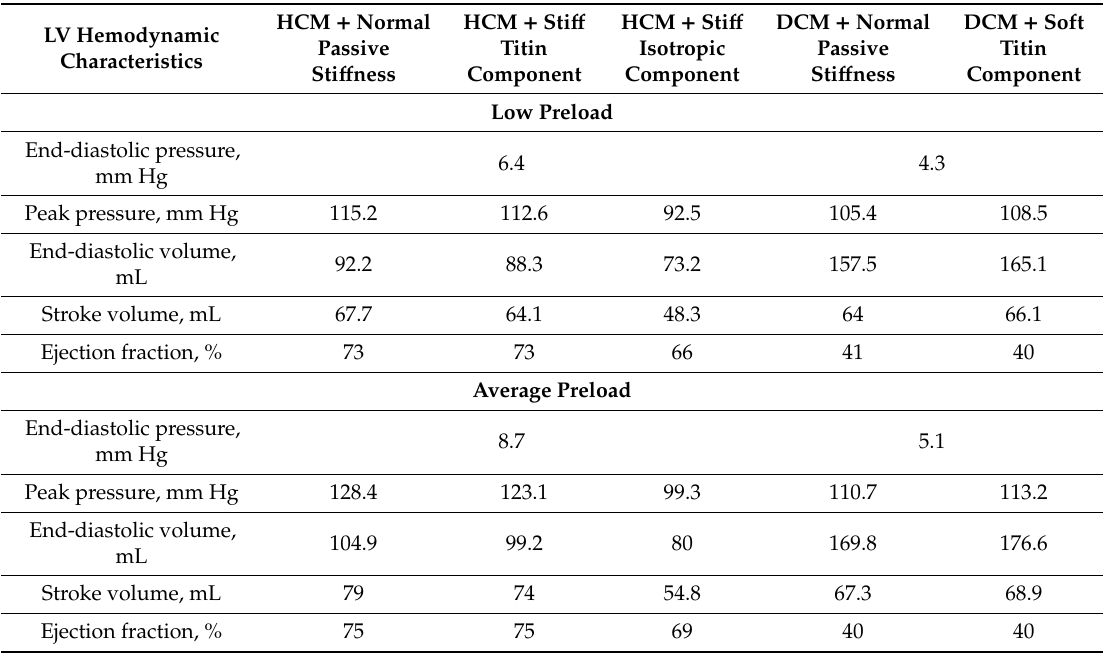
Table 1. The e ff ects of passive myocardial sti ff ness on the model LV performance at HCM and DCM. LV